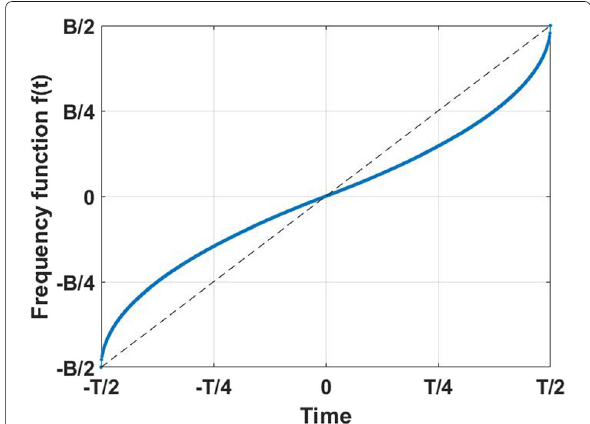
Fig. 1 Typical frequency function from the NLFM signal set (cid:2) , which is monotonically nondecreasing and has temporal midpoint antisymmetry